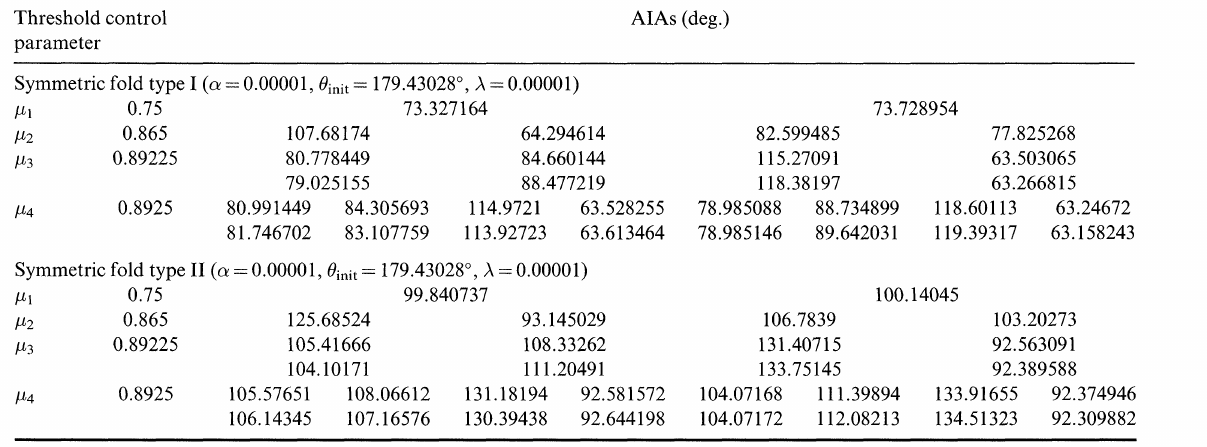
TABLE V AIAs of the fold dynamical system following time dependent stress control parameters (,0 =0.00001" c0 =0.00001 or 0t= 179.43028; No. of iterations 3 x 104) Stress modulation parameter (#) to control time dependent stress dynamics